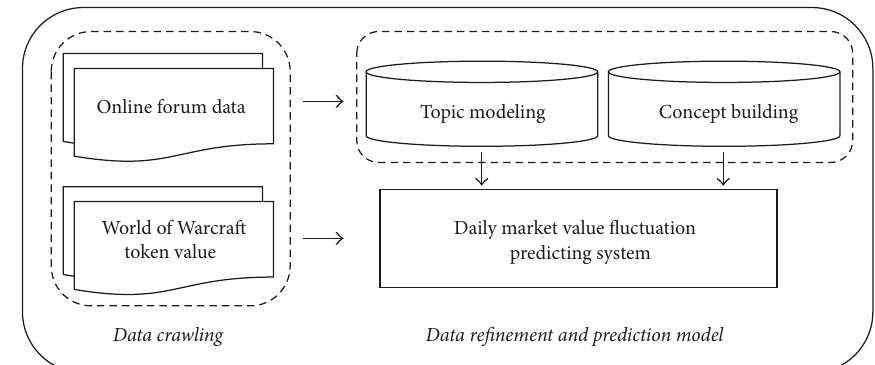
Figure 2: Overview of the proposed